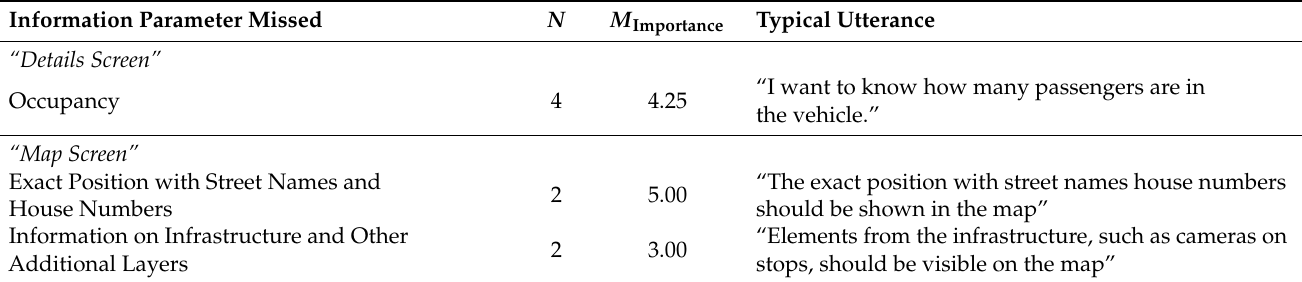
Table 5. Overview of missing information parameters.